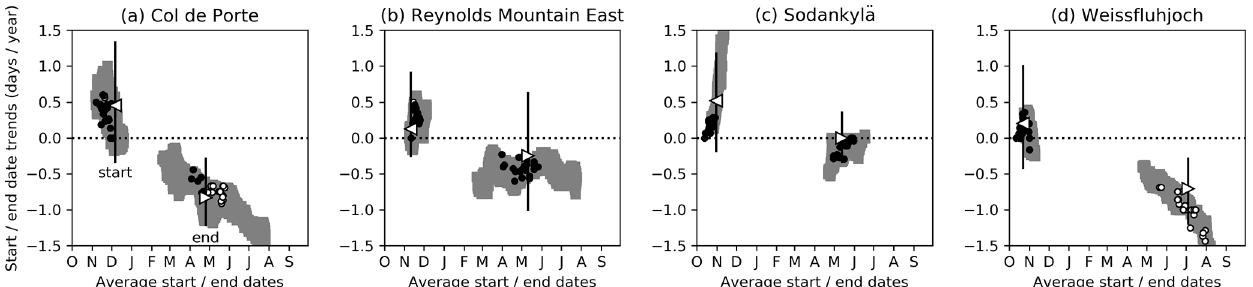
Figure 4. Scatter plots of averages and trends in start and end dates of continuous seasonal snow cover observed at the sites (triangles) and predicted by the ESM-SnowMIP models (open circles for significant trends, filled circles for insignificant trends) and 2PM (grey). Vertical bars show 95% confidence intervals on observed start ( (cid:67) ) and end ( (cid:66) ) date trends.